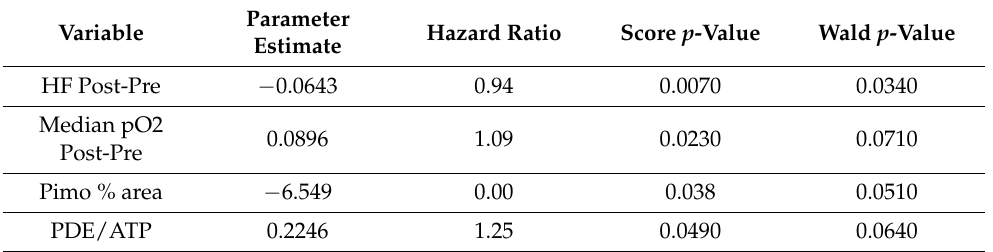
Table 1. Physiological Predictors of Time to Local Failure: Thermal Dose Escalation Trial.